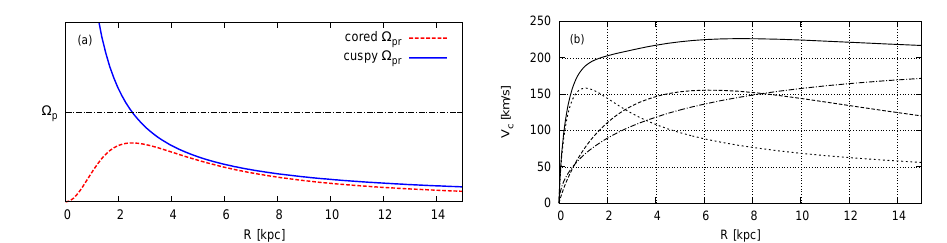
Fig. 1. (a) Precession curves Ω pr for typical cored (dashed line) and cuspy (solid line) galaxy models. (b) The total circular velocity profile V c ( R ) of the model with z d = 300 pc and contributions of the disk/bulge/halo